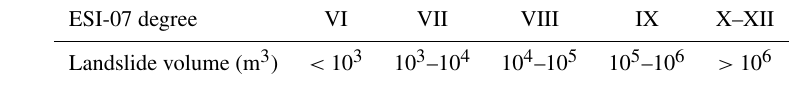
Table 2. Landslide volumes used in this study to assign ESI-07 local intensities.